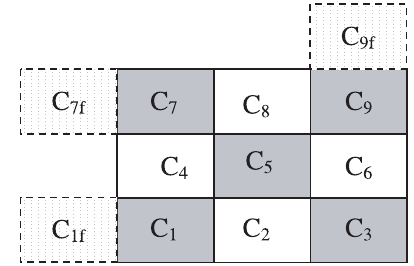
Fig. 2. Virtual cells on boundary condition surfaces.